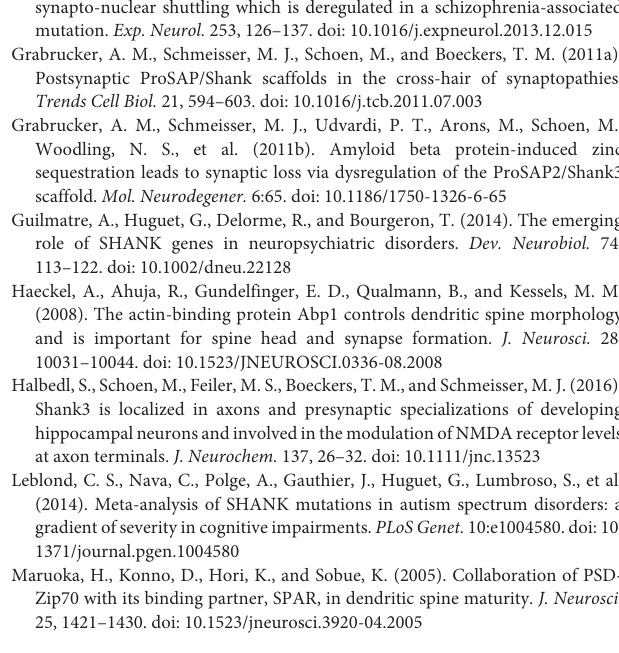
Supplementary Figure 2 | Analysis of PSD95 and LAPSER1 after ProSAPiP1 overexpression and knockdown in mature primary hippocampal neurons. (A) Primary hippocampal cultures were infected with either FUGW empty vector (Vector) or GFP-ProSAPiP1 and stained for PSD95 (red) or LAPSER1 (red) on DIV28 as indicated. The intensity of LAPSER1-positive puncta was significantly increased. (B) Primary hippocampal cultures were infected with either Scr or RNAi and stained for PSD95 (red) or LAPSER1 (red) on DIV28 as indicated. No significant difference was observed. (A,B) Scale bar: 10 µ m. Statistical analysis was performed using unpaired two-sided t -test. ∗ p < 0.05. n = 15 neurons from three independent